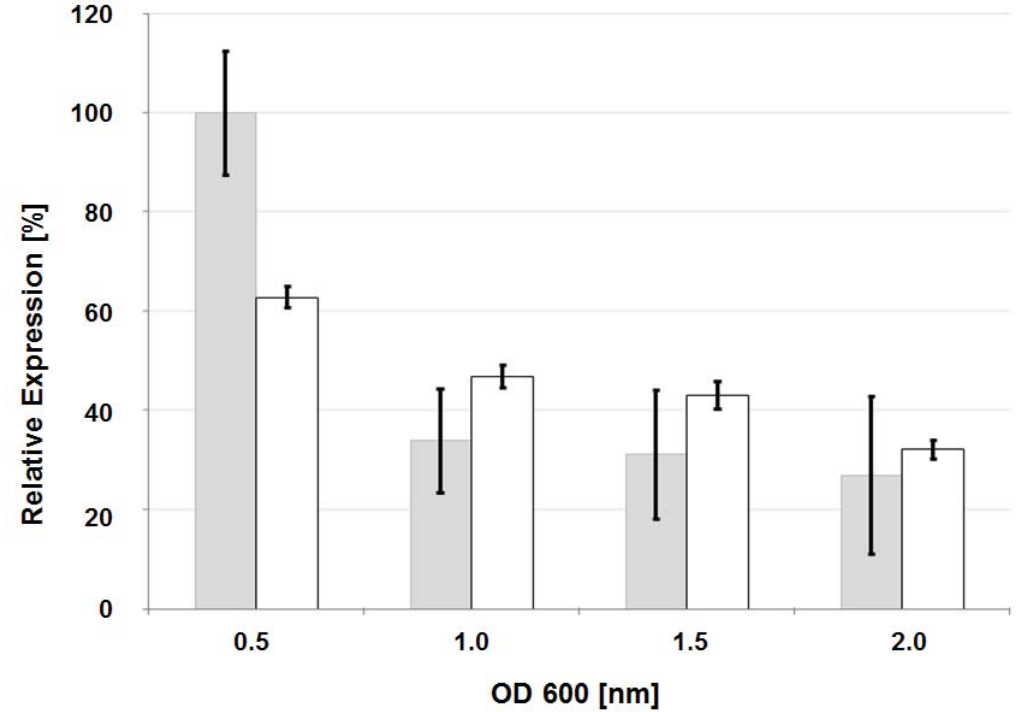
Figure 5. Quantitative Reverse Transcriptase PCR analysis of growth phase-dependent lsc and glycosyl hydrolase gene expression in P. syringae PG4180. Cells were grown at 18 °C in HS + glutamate as sole carbon source. Relative mRNA levels were related to the mean value determined for the signals of lsc gene of PG4180 at an OD defined as 100%. Data show the means and standard errors of two experiments with three replicates. Grey bars depicts the expression of lsc gene and white bars represent the glycosyl hydrolase gene expression in